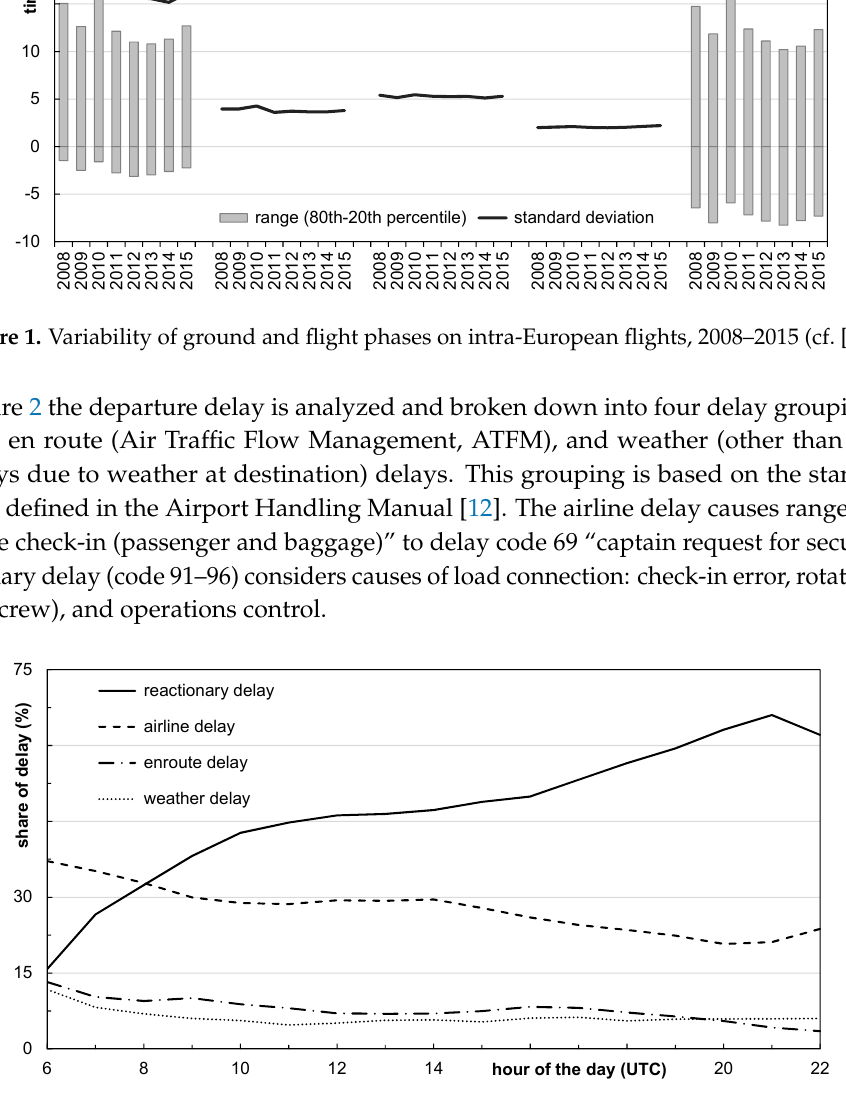
Figure 2. Average departure delay per flight by hour of the day (cf. [13]).